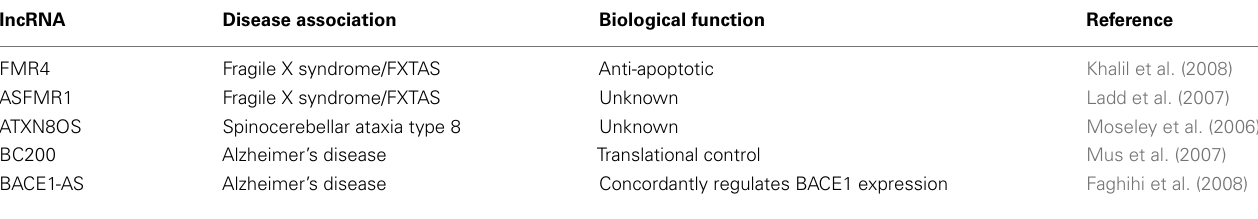
Table 2 | Examples of IncRNAs that are dysregulated in neurological disorders.